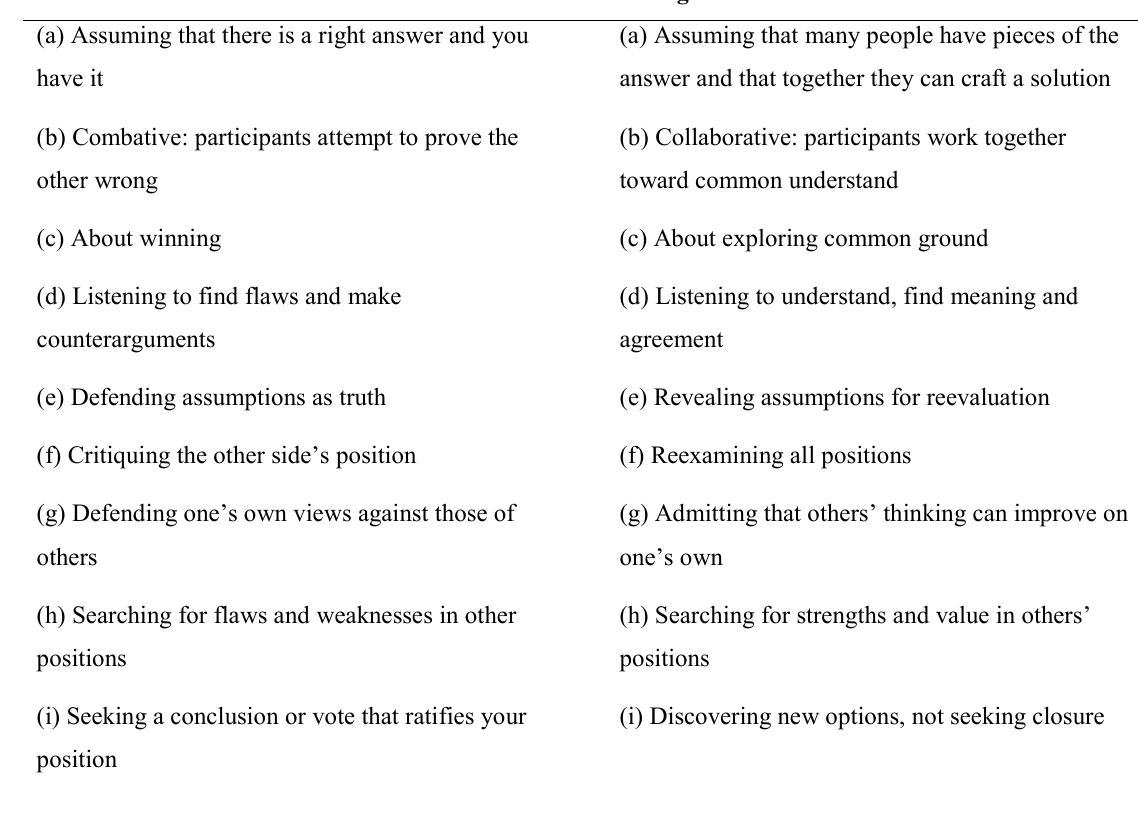
Table 2: Source: Daniel Yankelovich (1999) The Magic of Dialogue: Transforming conflict into cooperation , Simon & Schuster, New York,